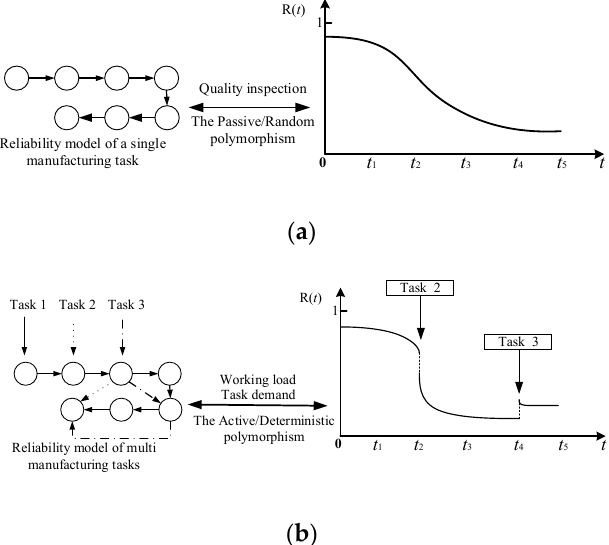
Figure 3. Reliability variation trends of manufacturing systems: ( a ) Basic reliability of manufacturing systems; ( b ) Mission reliability of manufacturing systems.